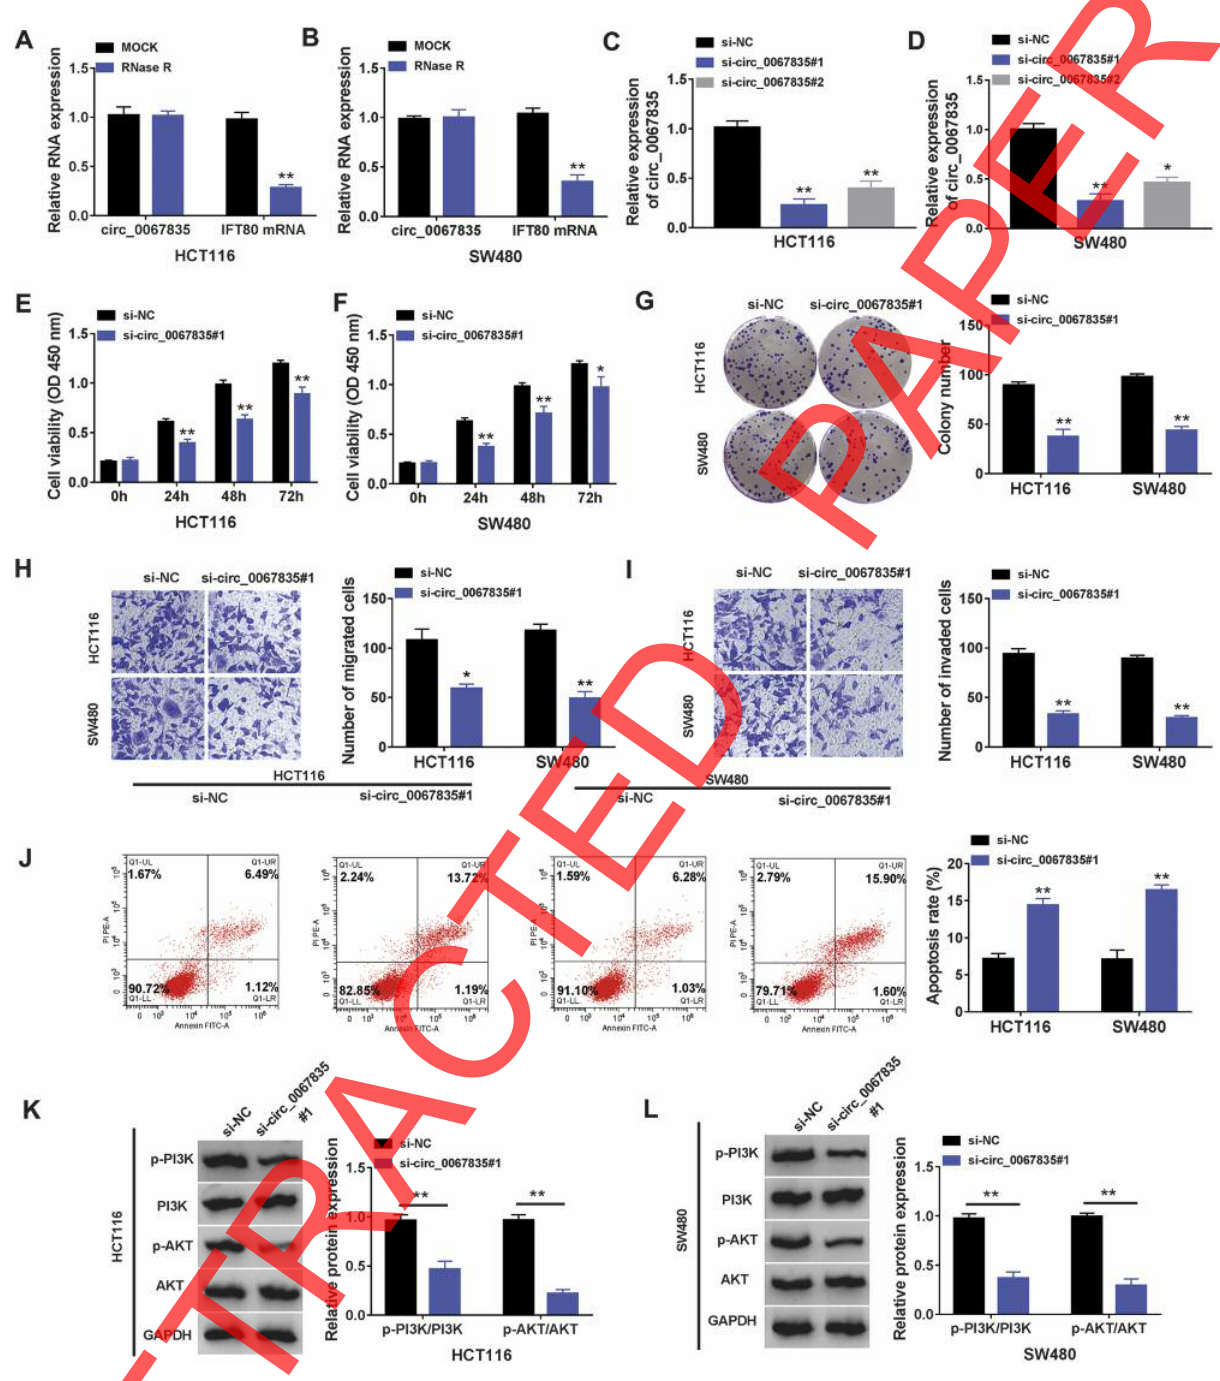
Fig. 2 Circ_0067835 deficiency impeded the proliferative and metastatic abilities of CRC cells. (A-B) qRT-PCR assay for the relative expression of circ_0067835 and IFT80 mRNA in RNA isolated from HCT116 and SW480 cells treated with RNase R or not (MOCK). (C- D) qRT-PCR assay for relative expression of circ_0067835 in HCT116 and SW480 cells transfected with si-NC, si-circ_0067835#1 or si-circ_0067835#2. (E-L) HCT116 and SW480 cells were transfected with si-NC or si-circ_0067835#1. (E-F) CCK-8 assay for the cell viability of transfected cells. (G) Colony formation assay for the clonogenicity of transfected cells. (H-I) Transwell assay for the migration and invasion of transfected cells. (J) Flow cytometry for the apoptotic rate in transfected cells. (K-L) Western blot assay for the levels of p-PI3K/PI3K and p-AKT/AKT proteins in transfected cells. * p < 0.05, ** p < 0.01.